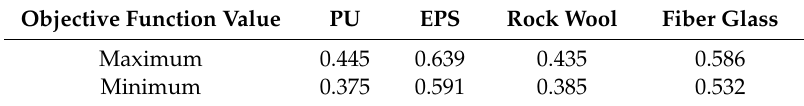
Table 4. Maximum and minimum values in the objective function for the 4 isolations.